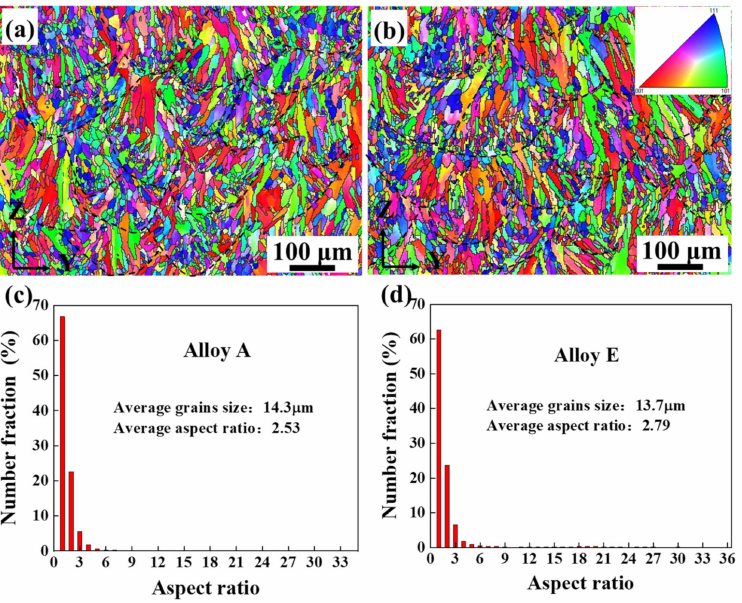
Figure 2. EBSD inverse pole figure (IPF)maps and the corresponding aspect ratio distribution: ( a , c ) Alloy A, ( b , d ) Alloy